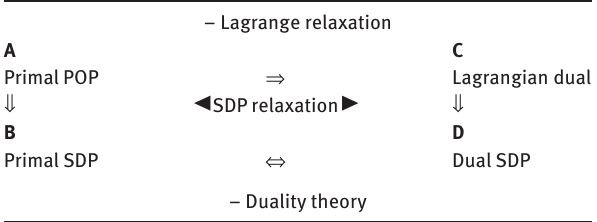
Table B1: Lagrange and semidefinite programming